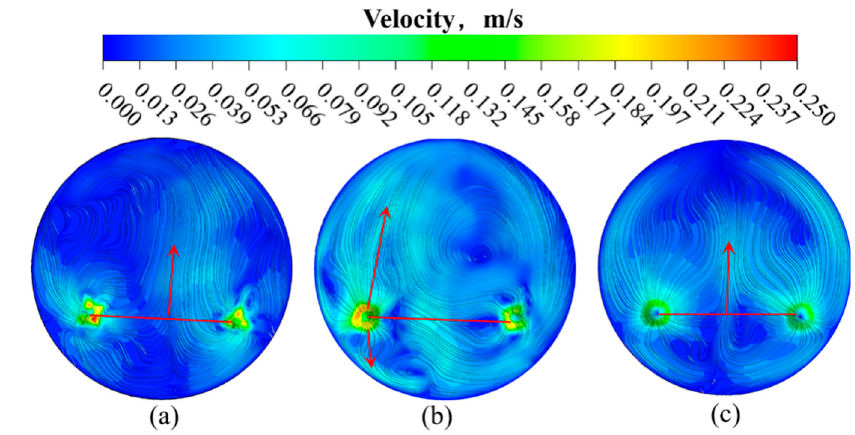
Figure 12. Velocity and streamlines on the free surface of liquid steel: ( a ) S-S mode, ( b ) S-P mode, and ( c ) P-P mode.